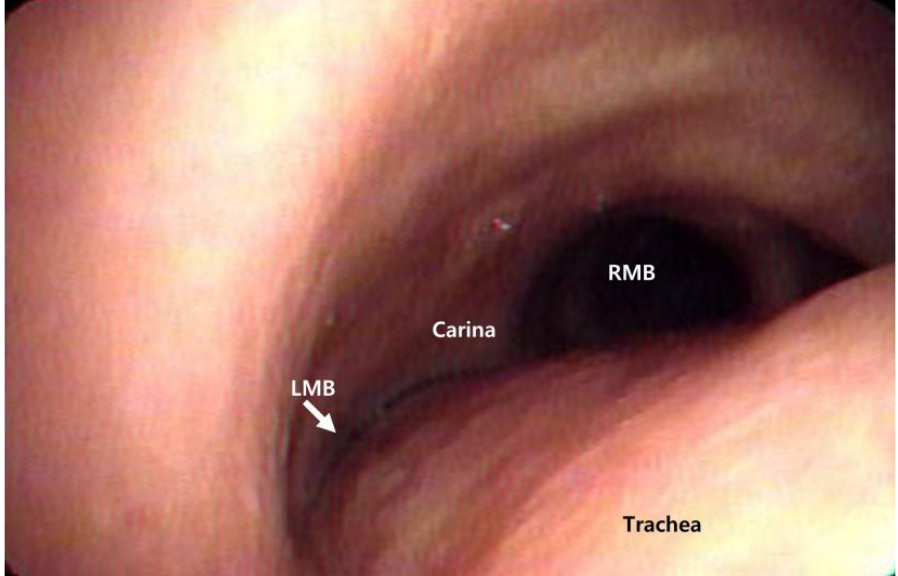
Figure 3. Bronchoscopic view of significant extrinsic compression of the posterior wall of trachea. The left main bronchus was also completely occluded by external compression of the esophageal stent at the site of tracheal bifurcation. LMB, left main bronchus; RMB, right main bronchus .